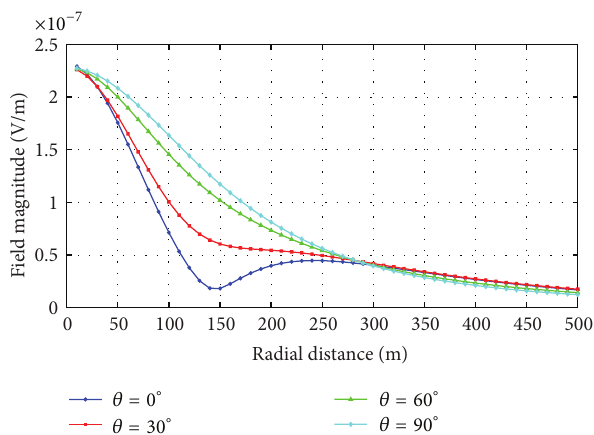
Figure 6: Curves of the total electric field magnitude with the radial distance.